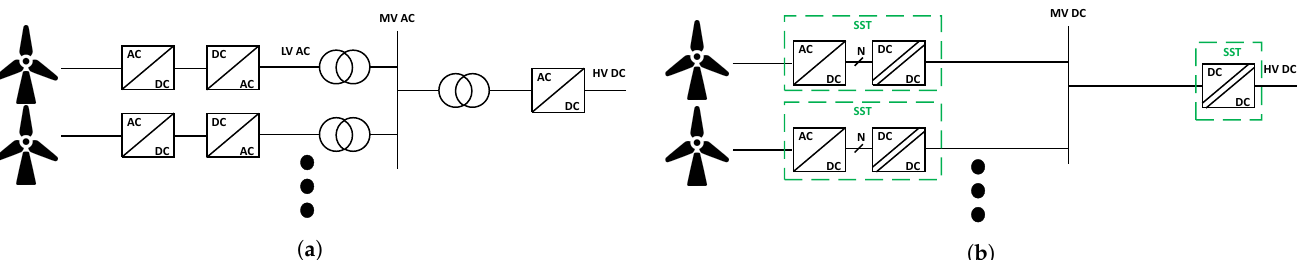
Figure 9. ( a ) Classical approach for power delivery at utility-scale offshore wind farms. Black dots indicate multiple wind turbines connected in parallel. ( b ) The alternative SST